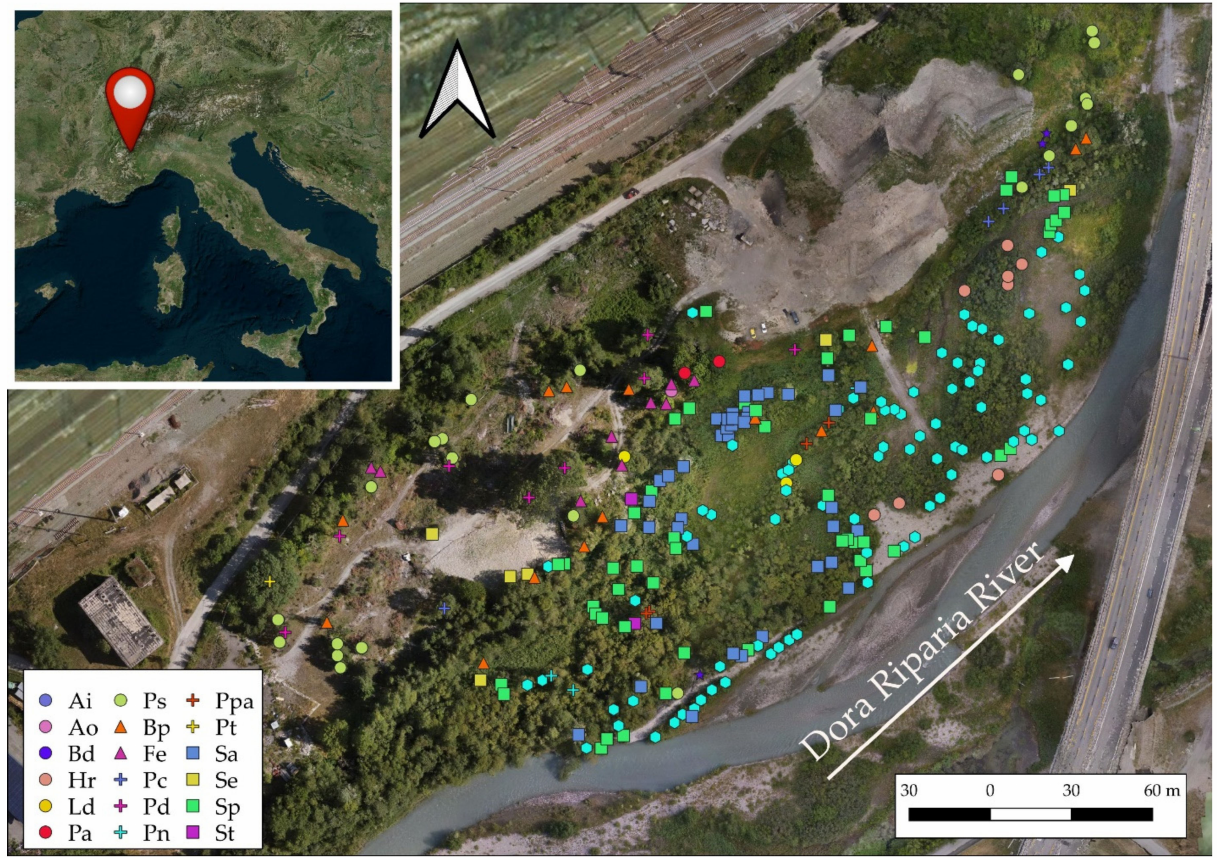
Figure 1. Study area in Salbertrand, North-West Italy. The symbols show the species mapped in the field. The species codes are explained in Table